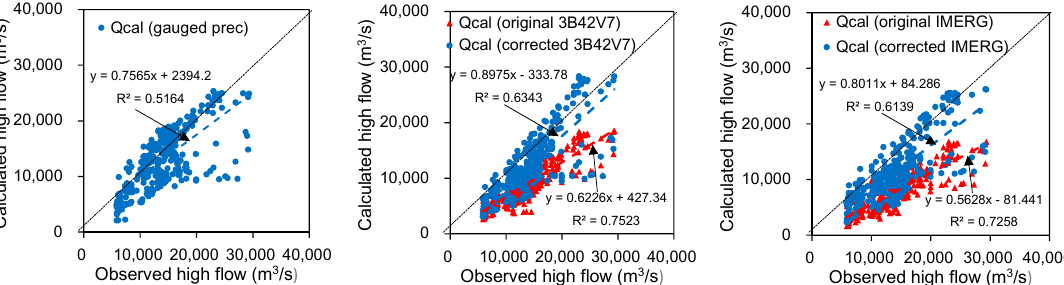
Figure 9. Scatter plots of the simulated high flow events using the gauge-based precipitation data, the original 3B42V7 and IMERG precipitation estimates, and their corrected data sets against the observed high flow at the five streamflow stations in the Chindwin River basin (1 April 2014–31 December 2015). The terms in the figure are the same as in Figure 8.